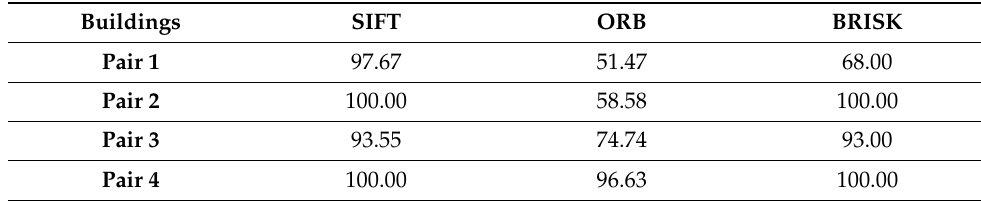
Table 5. Rates (%) of false positives of feature matching.